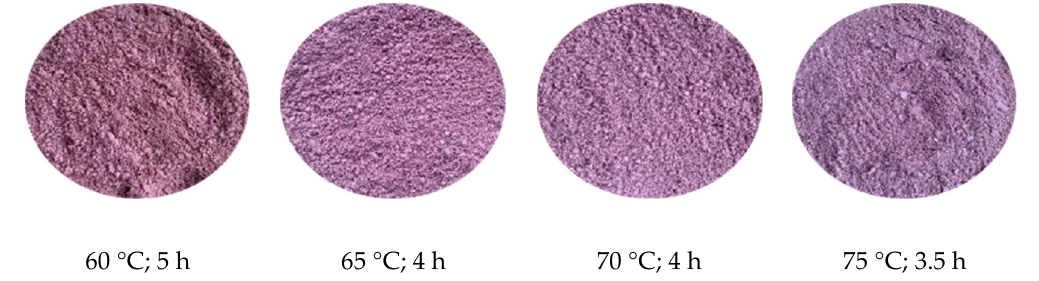
Figure 4. Mulberry powder color at various drying temperatures and durations. It was observed that drying at 65 °C for 4 h maintained the characteristic color of mulberries (Figure 5).